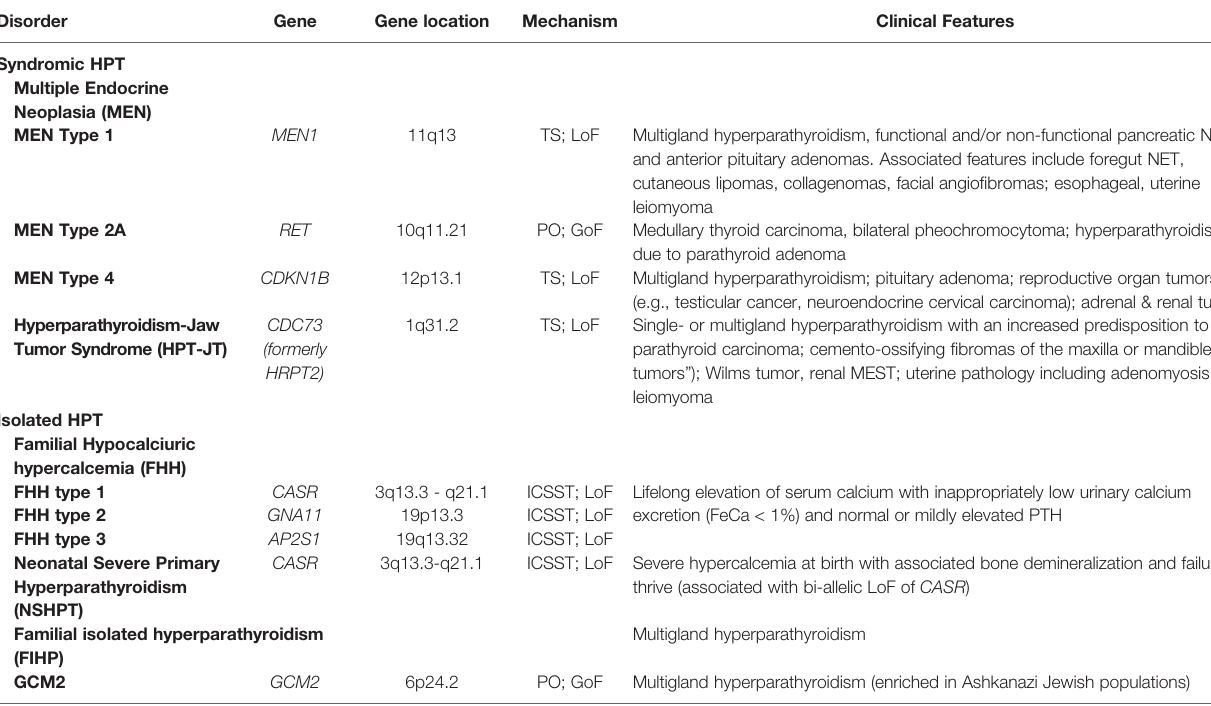
TABLE 1 | Hereditary